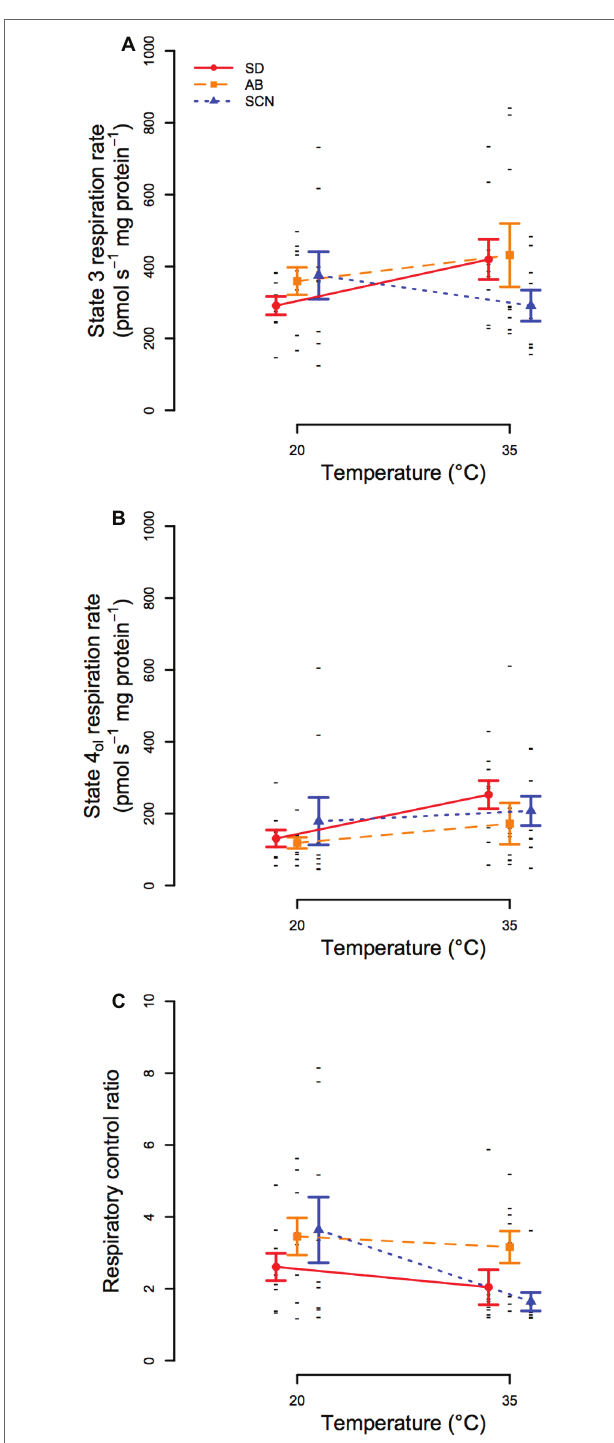
FIGURE 5 | State 3 (A) and state 4 ol (B) mitochondrial respiration and respiratory control ratios (RCRs; C ) at 20 and 35 ° C in San Diego (SD; red, circles, solid lines), Abalone Cove (AB; orange, squares, dashed lines), and Santa Cruz (SCN; blue, triangles, dotted lines) copepods. Data are presented as mean ± SEM, and small black dashes display values for each replicate. Significant effects of temperature for state 4 ol and RCR were detected by ANOVA, but post-hoc tests did not resolve any statistical differences among groups for all three